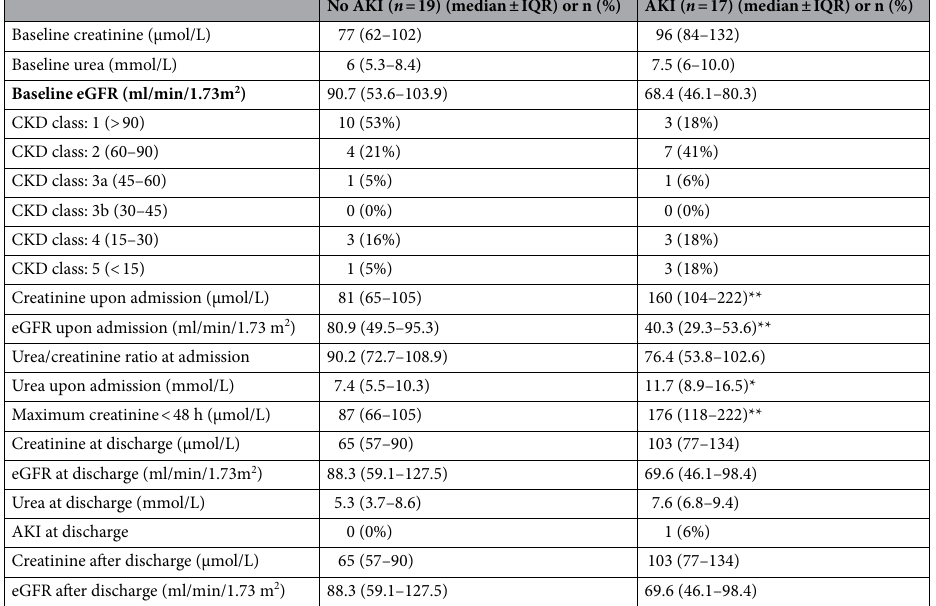
Table 2. Course of renal function. Although no changes in baseline renal function existed between patients with and without AKI, the serum creatinine level, eGFR upon admission, as well as the maximum serum creatinine reached during the first 48 h after hospitalization are different between groups. AKI acute kidney injury, CKD chronic kidney disease, eGFR estimated glomerular filtration rate, IQR interquartile range, */**means p <